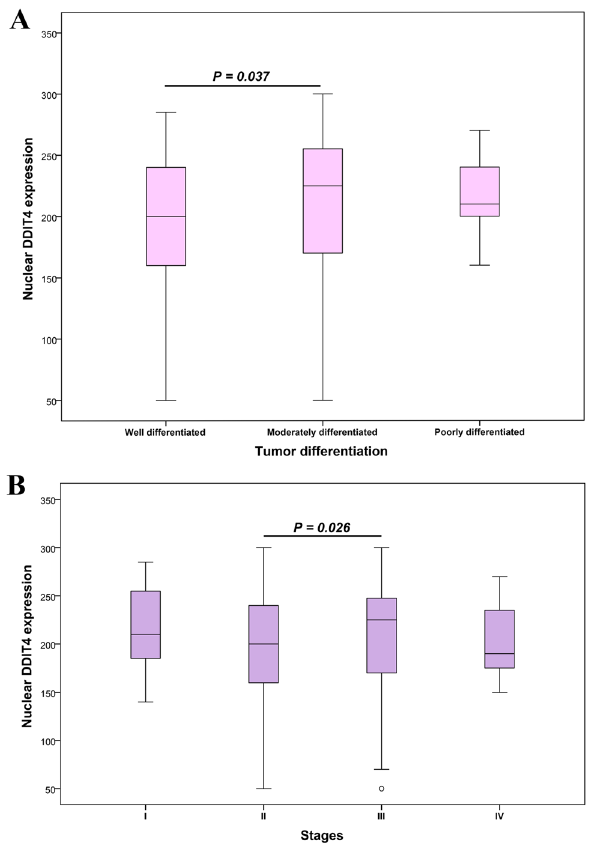
Figure 6. Box plot analysis of DDIT4 expression levels in tumor differentiation groups and TNM stages. The bold line precisely represents median expression levels of DDIT4. ( A ) The result of data analysis showed a statistically significant association in the median nuclear expression of DDIT4 between well and moderately tumor differentiation ( P = 0.037). ( B ) A statistically significant association was observed in the median nuclear expression of DDIT4 between stages II and III ( P =